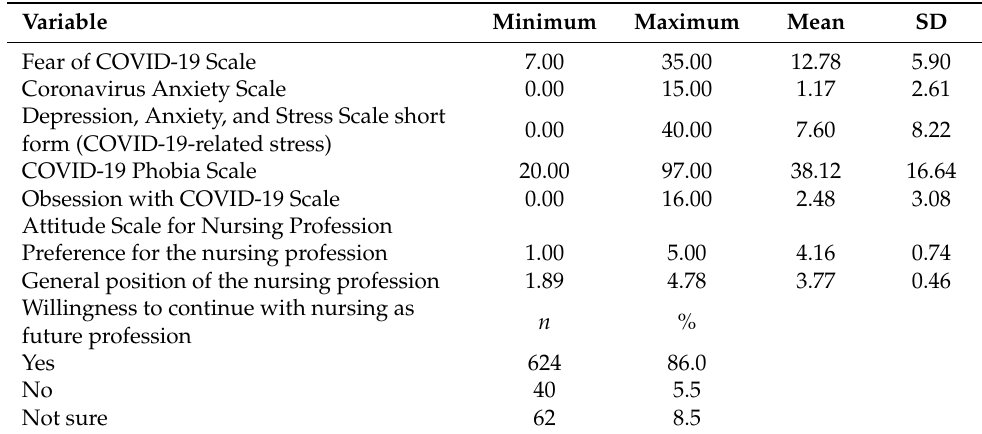
Table 2. Descriptive analyses of the study variables ( n =